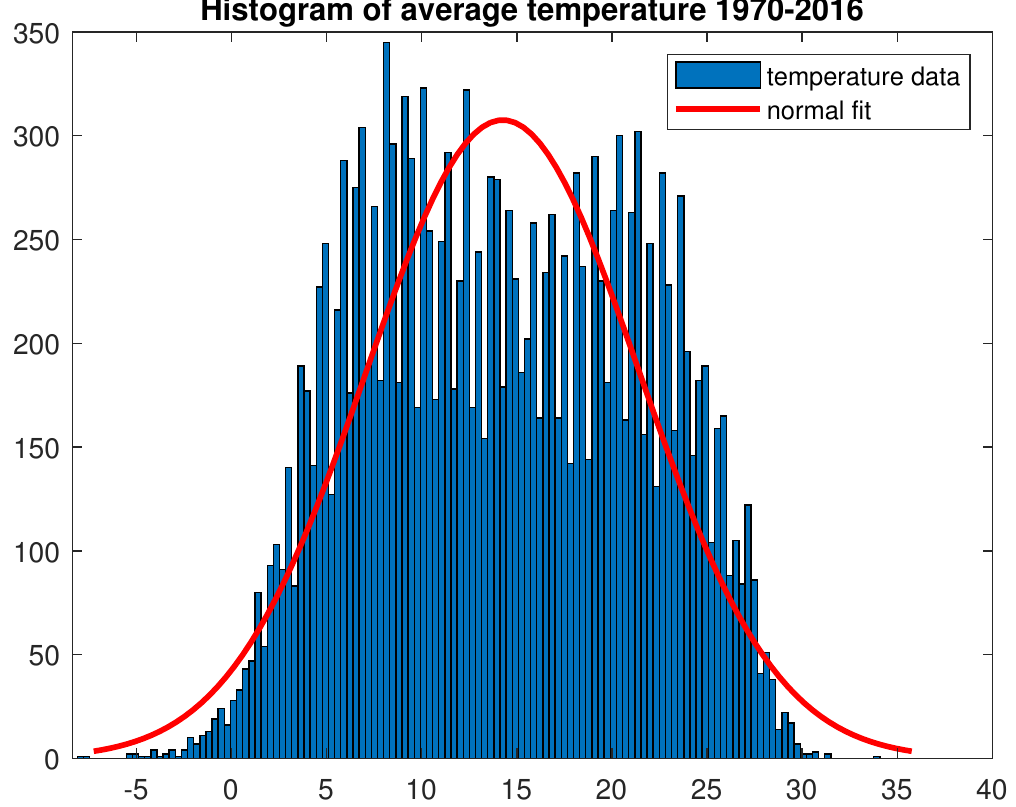
Figure 2. Historical distribution for daily temperature, Arezzo,